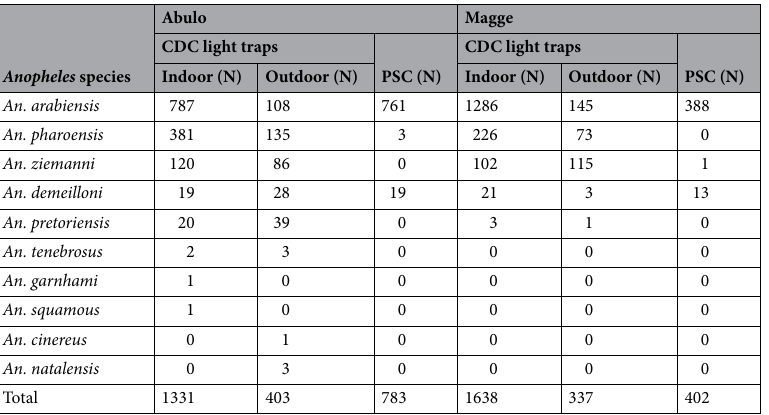
Table 1. The species of Anopheles and the total number of mosquitoes caught in indoor and outdoor Centre of Disease Control light traps and collected following pyrethrum spray treatment.